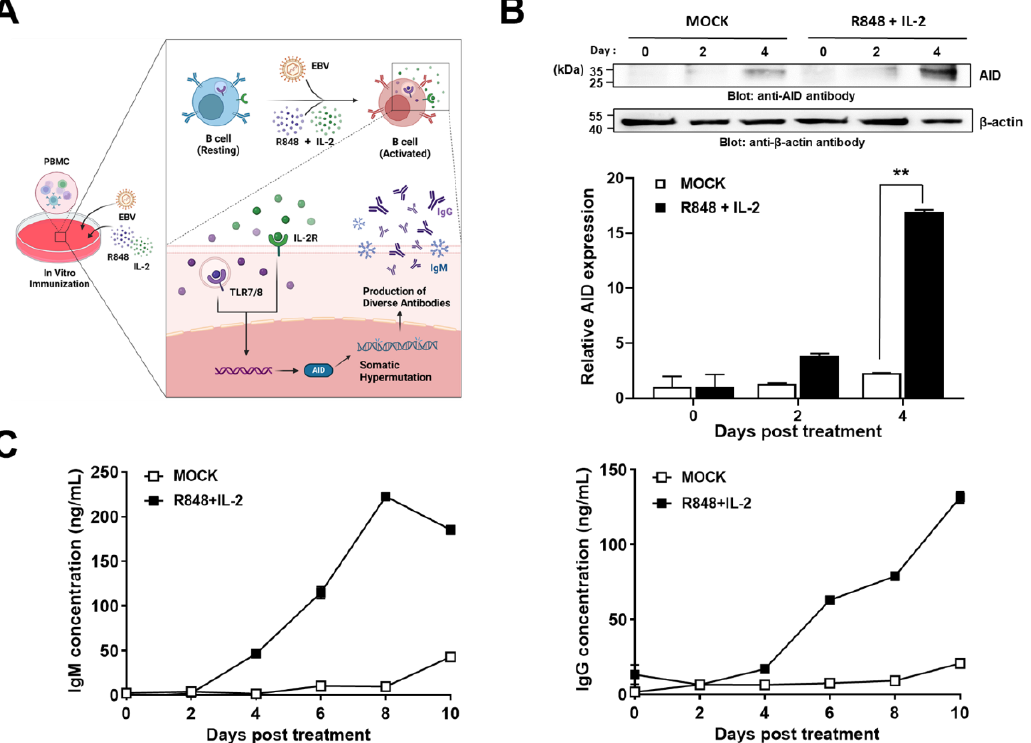
Figure 1. In vitro immunization and biochemical characterization of human peripheral blood mononuclear cells (hPBMCs) stimulated with a combination of R848 and interleukin-2 (IL-2). ( A ) Schematic representation showing overall experimental procedures and key characteristic mechanisms in B cell activation. hPBMCs were cultured in the presence or absence of a combination of R848 and IL-2 for the indicated time. ( B ) The prepared cell extracts were subjected to immunoblot analysis to check the protein expression of activation-induced cytidine deaminase. After the quantitation of band intensity, the protein expression was represented on a bar graph. ( C ) Immunoglobulin M or immunoglobulin G production from the culture supernatants of the cultured hPBMCs, obtained every two days after the treatment, was analyzed using enzyme-linked immunosorbent assay. All values represent the mean ± standard error of the mean from duplicate measurements of one of two independent experiments. Data were statistically analyzed with two-tailed Student’s t tests (** p < 0.01).